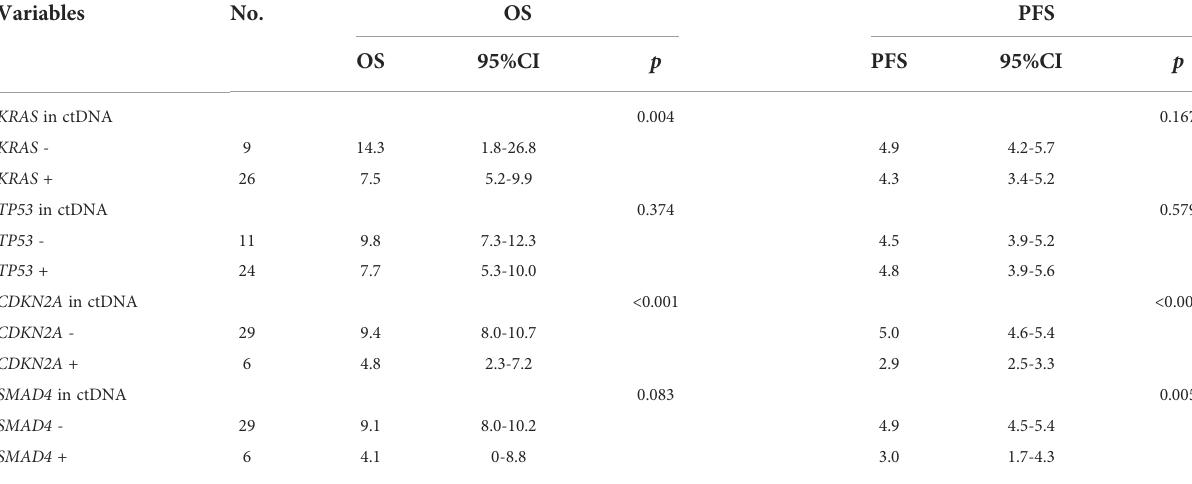
TABLE 2 Association analysis of four main driver genes mutation in ctDNA with survival in 35 metastatic PAC patients.